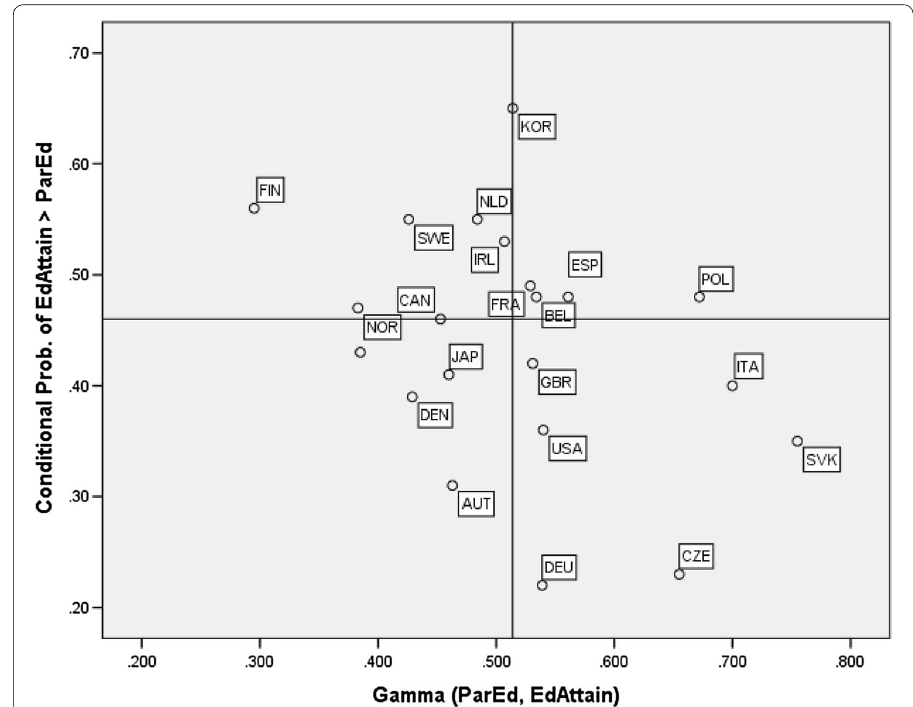
Fig. 1 Correlation between Parental Education and Educational Attainment (Gamma coefficient) vs. Probability of Attaining Higher Education Level than Parents with no Tertiary Education (Median lines